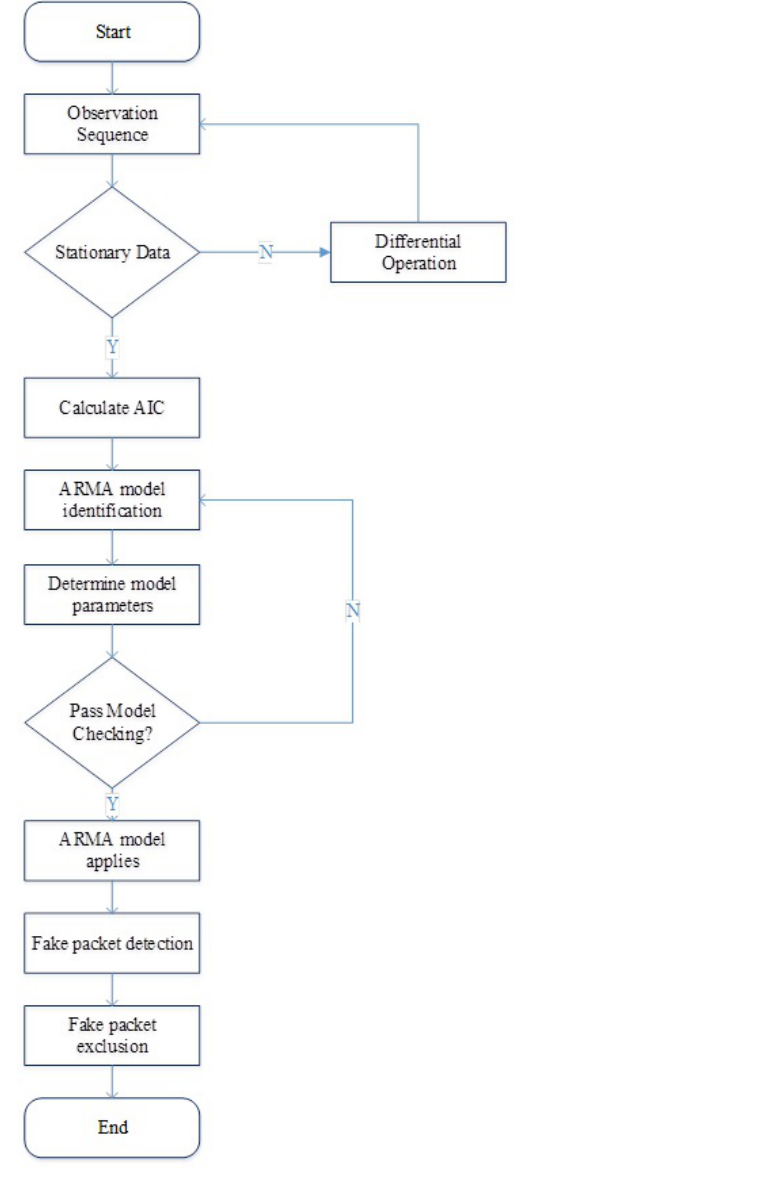
Figure 5. SFBARMA SDN